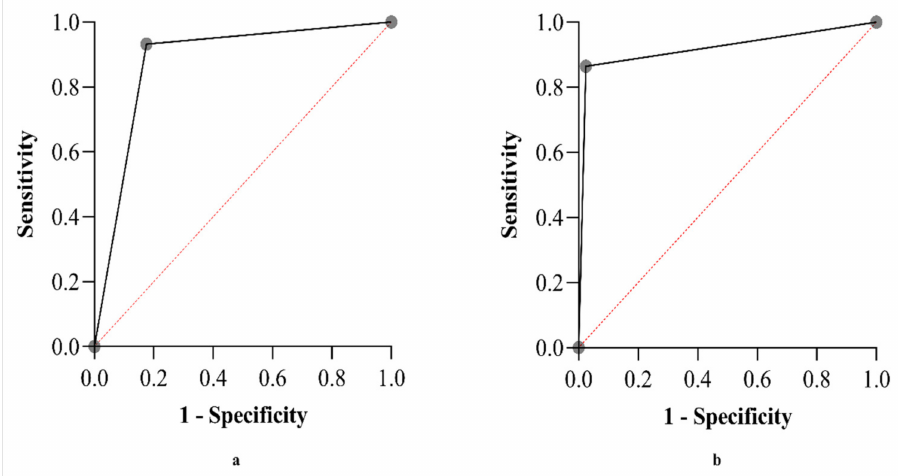
Figure 1. ROC curves depicting performances of GeneXpert ( a ) and LPA ( b ) in detecting rifampicin resistance. GeneXpert has shown the predictive measures in accuracy of 0.847, specificity of 0.825 and sensitivity of 0.932, with cut-off value set at 0.5.